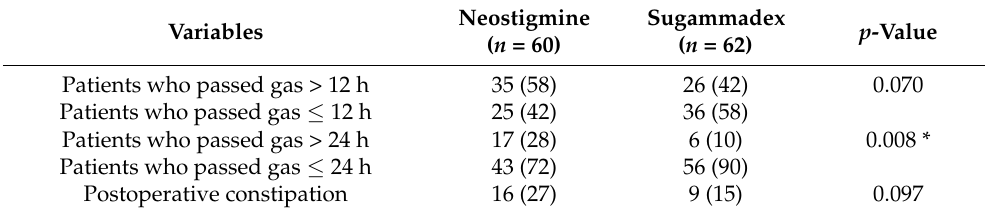
Table 3. Postoperative bowel